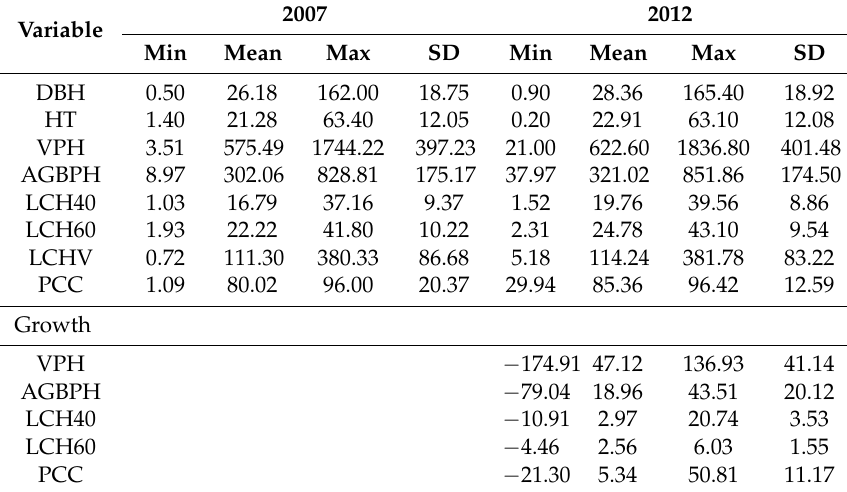
Table 1. Minimum (Min), average (Mean), maximum (Max), and standard deviation (SD) of the selected variables obtained from ground measurement or lidar. A total of 3479 and 3268 trees were observed in the ground measurements in the year 2007 and 2012,